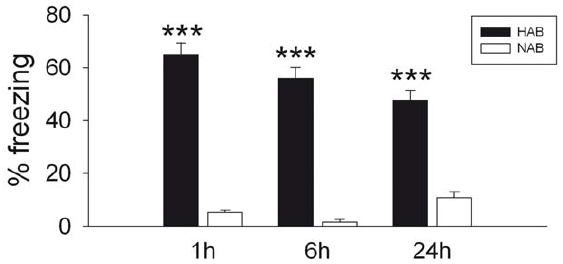
Figure 3. Short- and long-term recall of cued conditioned fear in HAB and NAB mice. CS only was presented to separate HAB and NAB groups 1 h, 6 h (short-term) or 24 h (long-term) after cued fear conditioning. Irrespective of consolidation period, HAB mice showed pronounced freezing during the fear expression test, but not NAB mice. Data are presented as means 6 SEM. n =6–8 per experimental group. *** p , 0.001 HAB vs. NAB.